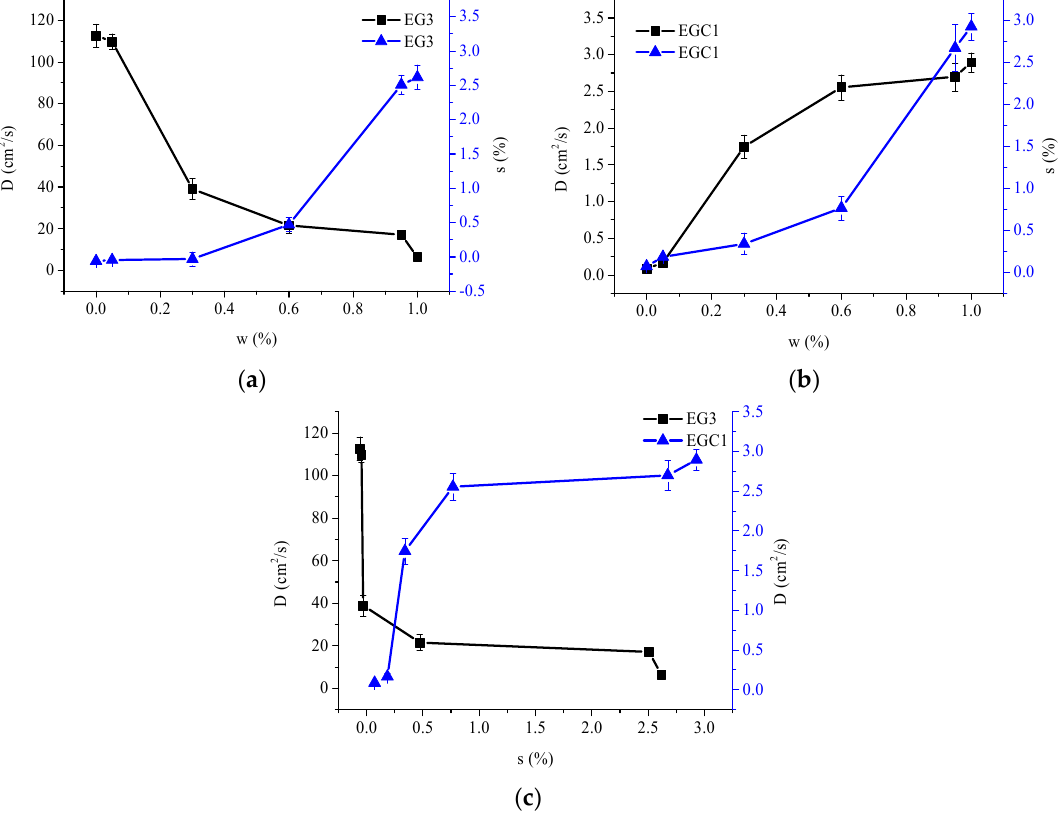
Figure 7. D values of CEOs released from films EG3 ( a ) and EGC1 ( b ) to aqueous ethanol of w = 0, 0.05, 0.3, 0.6, 0.95 and 1, respectively; s at equilibrium of films EG3 ( a ) and EGC1 ( b ) contacting aqueous ethanol of w = 0, 0.05, 0.3, 0.6, 0.95 and 1, respectively; D values at different s of CEOs released from films EG3 and EGC1 to aqueous ethanol ( c ), respectively.